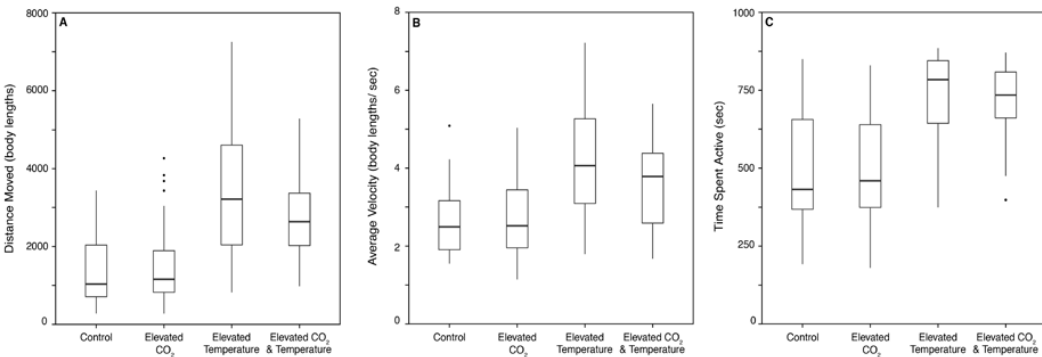
Figure 2. The effect of elevated CO 2 and temperature treatments on: ( A ) the total distance moved, standardized by body length; ( B ) average velocity, standardized by body lengths; and ( C ) the time spent active during a 15 min open field test of larval yellowtail kingfish. Boxplots show median and inter-quartile range. N = 29, 38, 29, and 34, respectively.